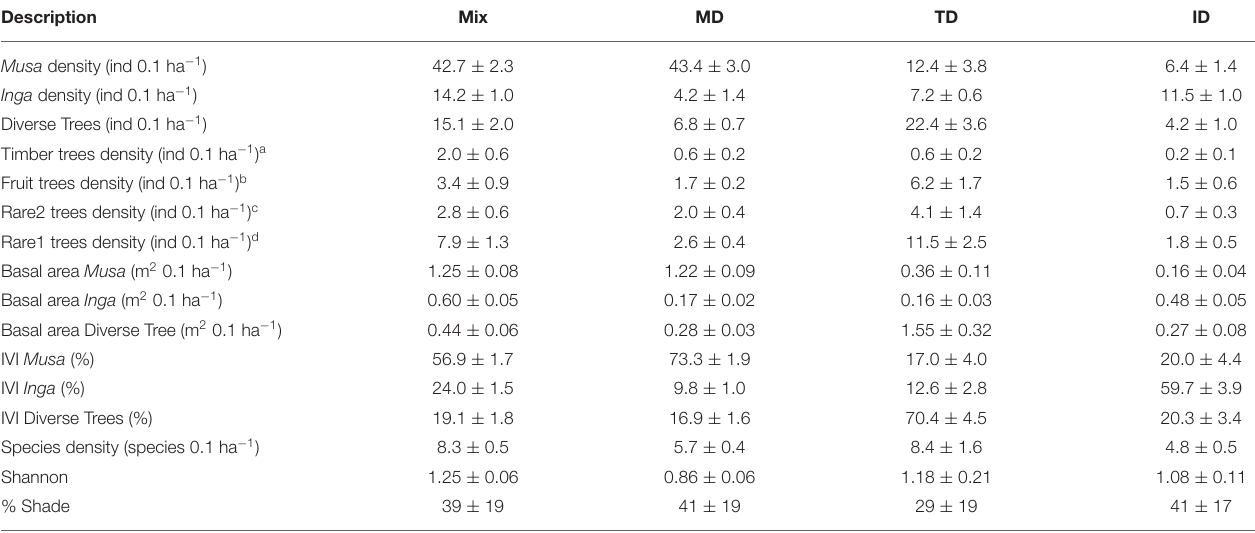
TABLE 2 | Characteristics of four typologies generated from the three data sets of composition of coffee multi-strata vegetation. Description